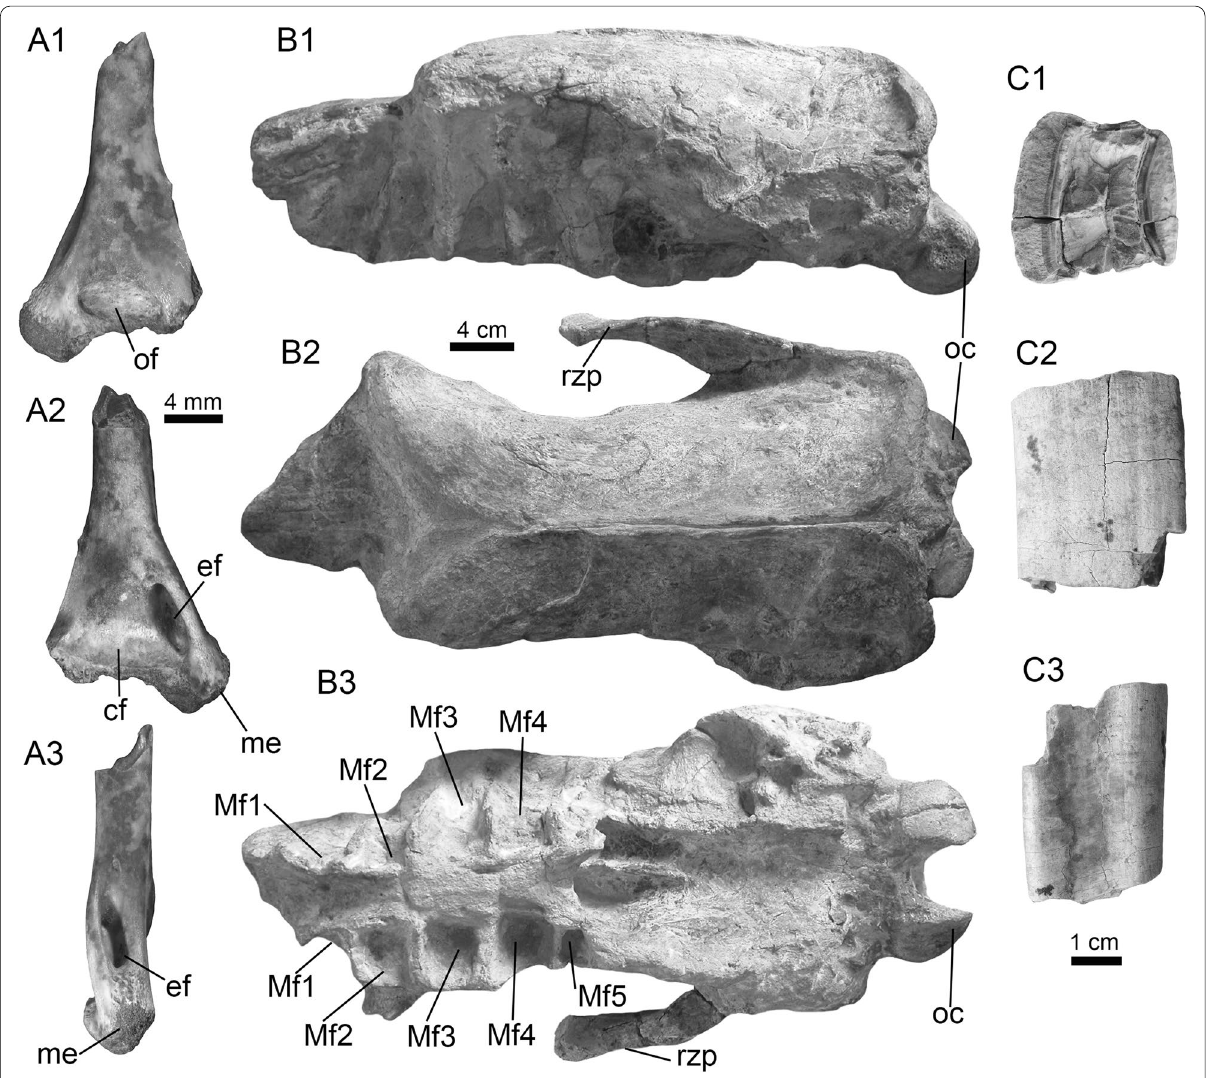
Fig. 22 Metatheria (Didelphidae) and Xenarthra (Megatheriidae) from the Vergel ( A1 – B3 ) and Cocuiza ( C1 – C3 ) members. A1 – A3 Right humerus (AMU‑CURS‑1140) of cf. Didelphis sp. B1 – C3 Skull ( B1 – B3 AMU‑CURS‑184) and left molariform Mf3 ( C1 – C3 AMU‑CURS‑1303) cf. † Proeremotherium sp. Views: anterior ( A2 , C2 ), dorsal ( B2 ), labial ( C3 ), mesial ( A3 ), posterior ( A1 ), left lateral ( B1 ), occlusal ( C1 ), and ventral ( B3 ). cf coronoid fossa, ef entepicondylar foramen, lc lateral condyle, mc medial condyle, me medial epicondyle, Mf upper molariform, oc occipital condyle, of olecranon fossae, rzp right zygomatic